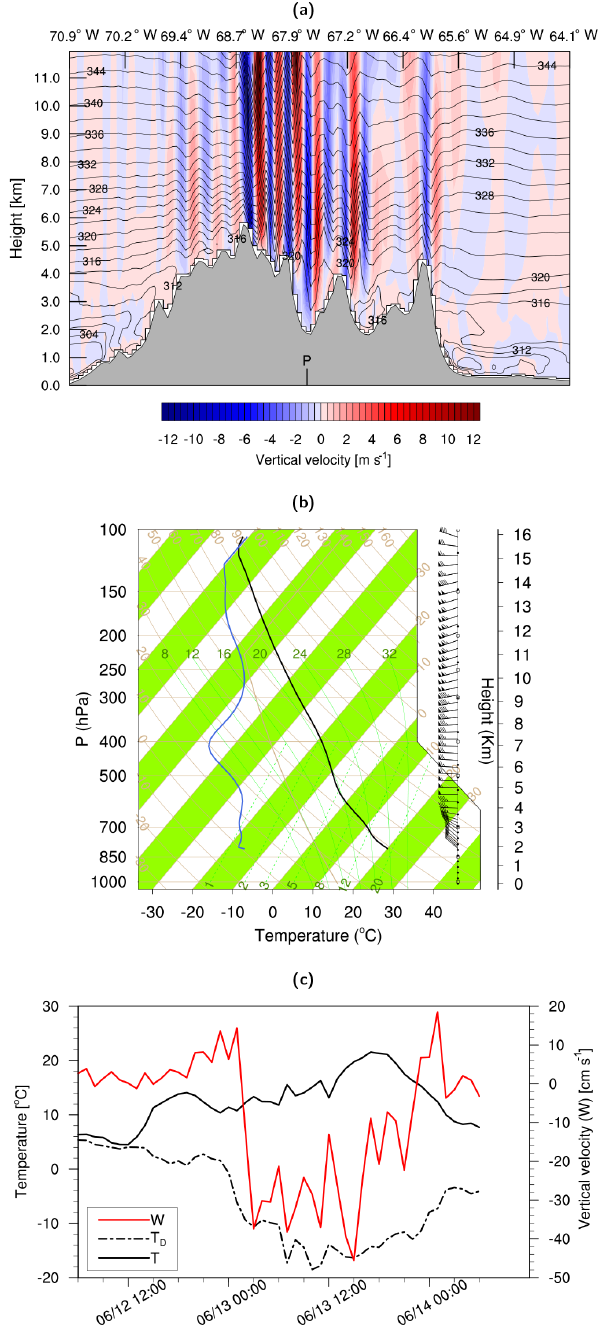
Figure 9. Features of a zonda event in the northern Fiambalá Basin according to WRF-ARW output. (a) Vertical cross section of equiv- alent potential temperature (K) and vertical wind velocity (ms − 1 ) through the Andes along the latitude of P (27.25 ◦ S) at 16:00UTC on 13 June. (b) Skew- T log- P diagrams at P (27.25 ◦ S, 67.7 ◦ W) at 16:00UTC on 13 June. (c) Time series at P for temperature ( T ), dew point temperature ( T D ), and vertical velocity ( W ). Tem- peratures at 2m and vertical wind velocity at the first model level ( ∼ 27.5m).